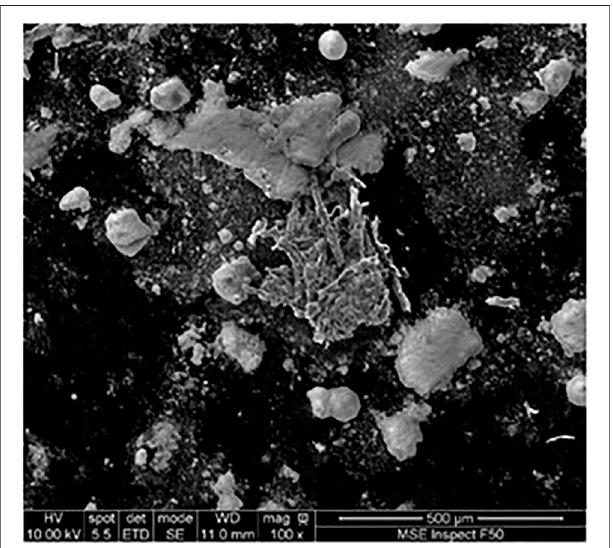
FIGURE 4 | Example SEM image of fl y ash particles. Other images showed similar variations in particle size and shape.